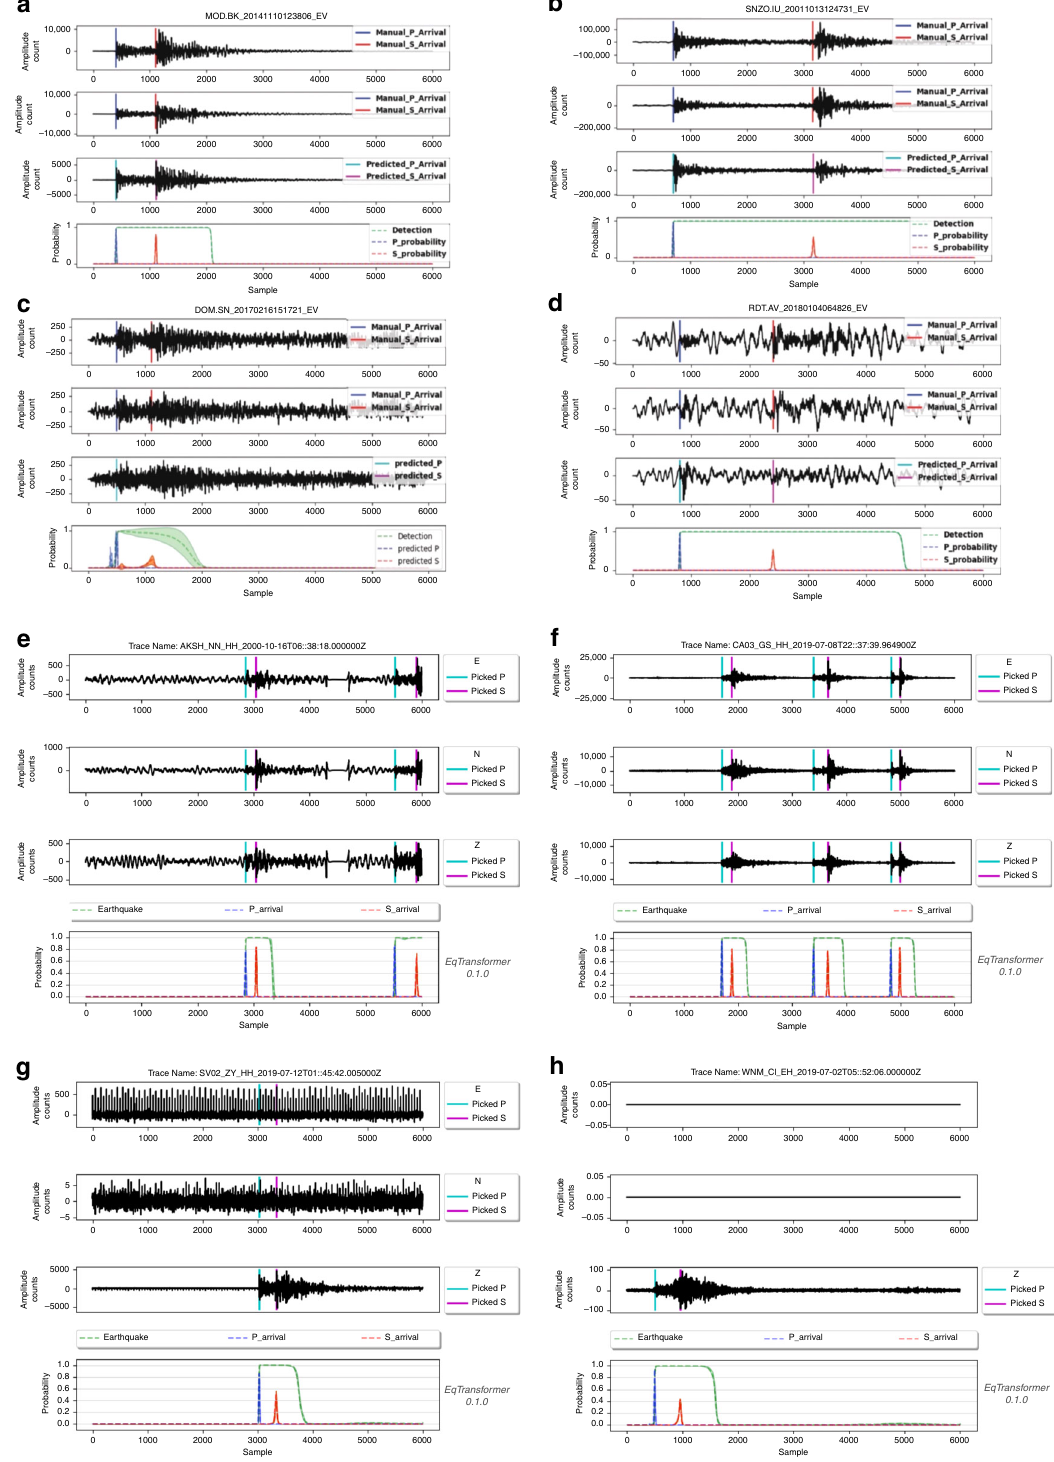
Fig. 4 Test results. Four representative waveforms ( a – d ) from the test set and four waveforms from applying the model to continuous data in Tottori, Japan ( e ) and Redgcrest, California ( f – h ) presenting performance of the model on different types of data. Each waveform is 60 seconds long with 100 samples per second band-bass fi ltered from 1-45 Hz. Each panel shows three channel waveforms on top and output predictions of the model for earthquake signal detection, P-arrival, and S-arrival at the bottom. In a to d , the vertical color-coded lines on fi rst two channels are manual arrival time picks from catalogs. a is an event with the local magnitude of 2.2 recorded in 55 km distance from the epicenter, b is an event with the local magnitude of 4.3 recorded 173 km away from the epicenter, c is an event with the local magnitude of 0.1 recorded 38 km away from the epicenter, and d is an event with the local magnitude of 2.0 recorded 110 km away from the epicenter. The output probabilities are presented as distributions that can represent variations or model uncertainties. e to h are detected events after applying the model to continuous data, representing the performance of the model when more than one event exists in a 1-minute window ( e and f ), when data contains gaps fi lled by zeros ( e ), when an event occurs near the edge ( e ), when two channels are broken or noisy ( g ), or when only one component data exists ( h